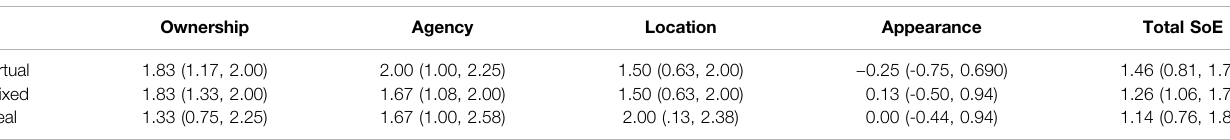
TABLE 3 | Descriptive statistics of the embodiment scores.